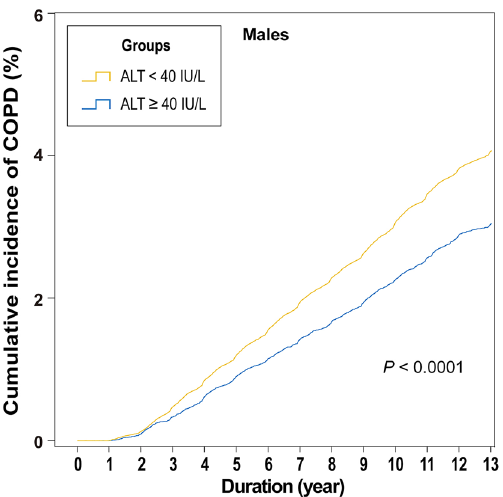
Figure 4. Kaplan–Meier curves of the cumulative COPD development in males. ALT alanine aminotransferase, COPD chronic obstructive pulmonary